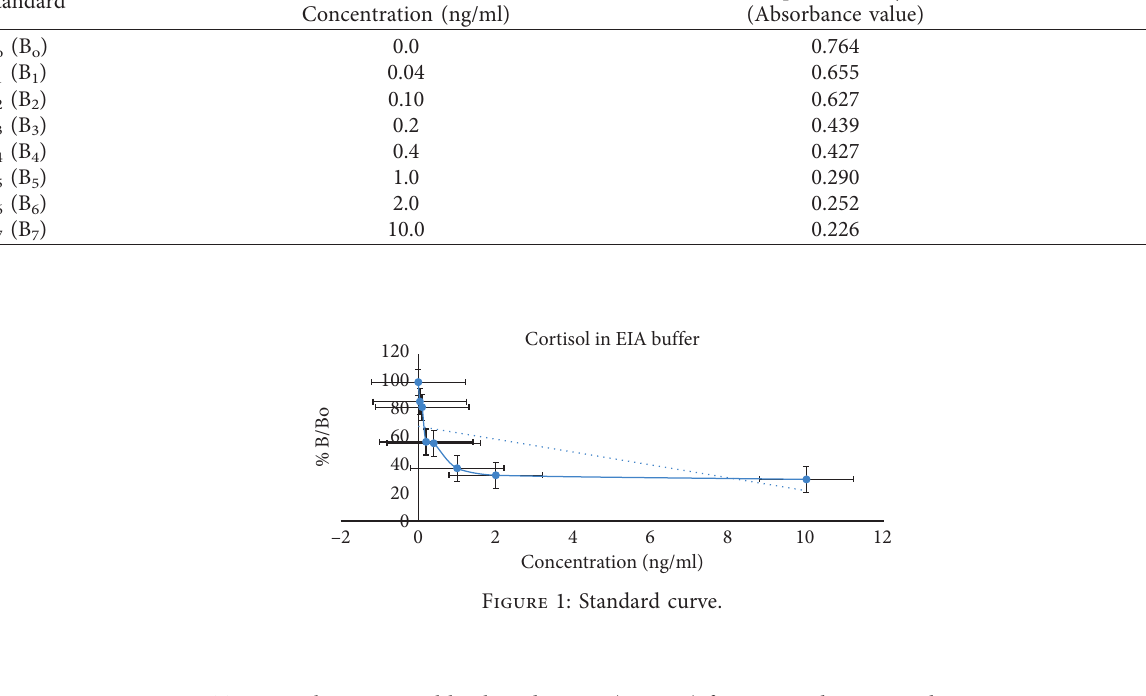
Table 2: Plasma cortisol levels and means ( P < 0 . 05) for HSD and LSD O. niloticus